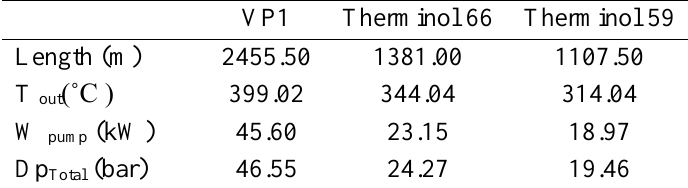
Table 3. Comparison of solar field parameters for different thermal oils considering maximum temperature limit for different oils